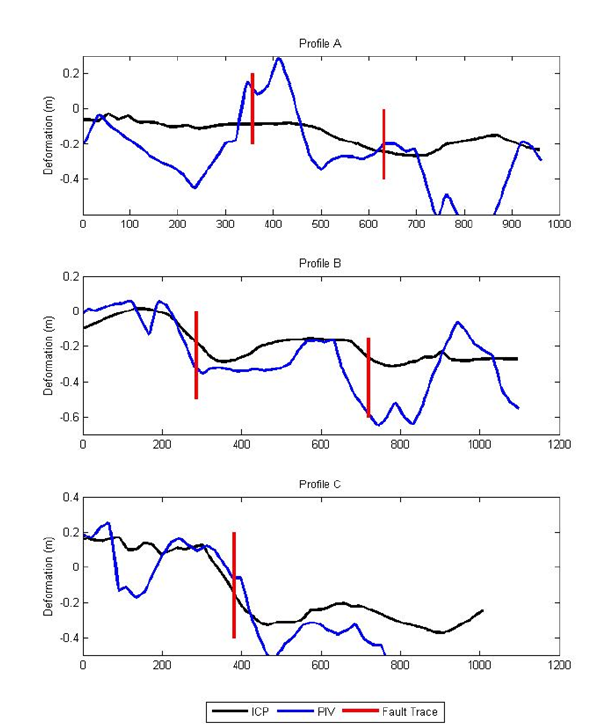
Figure 5. Profiles A-C (locations given in Figure 3) showing the estimated displacement from left to right for the June 2014 versus September 2014 point clouds with geodetic